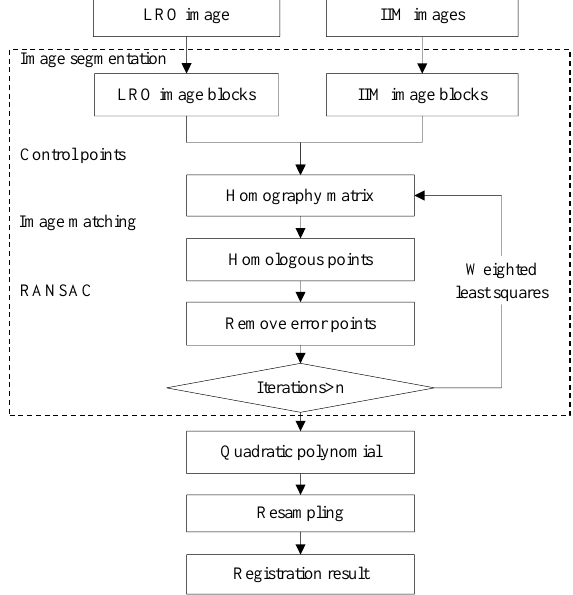
Figure 3. The accurate registration flow